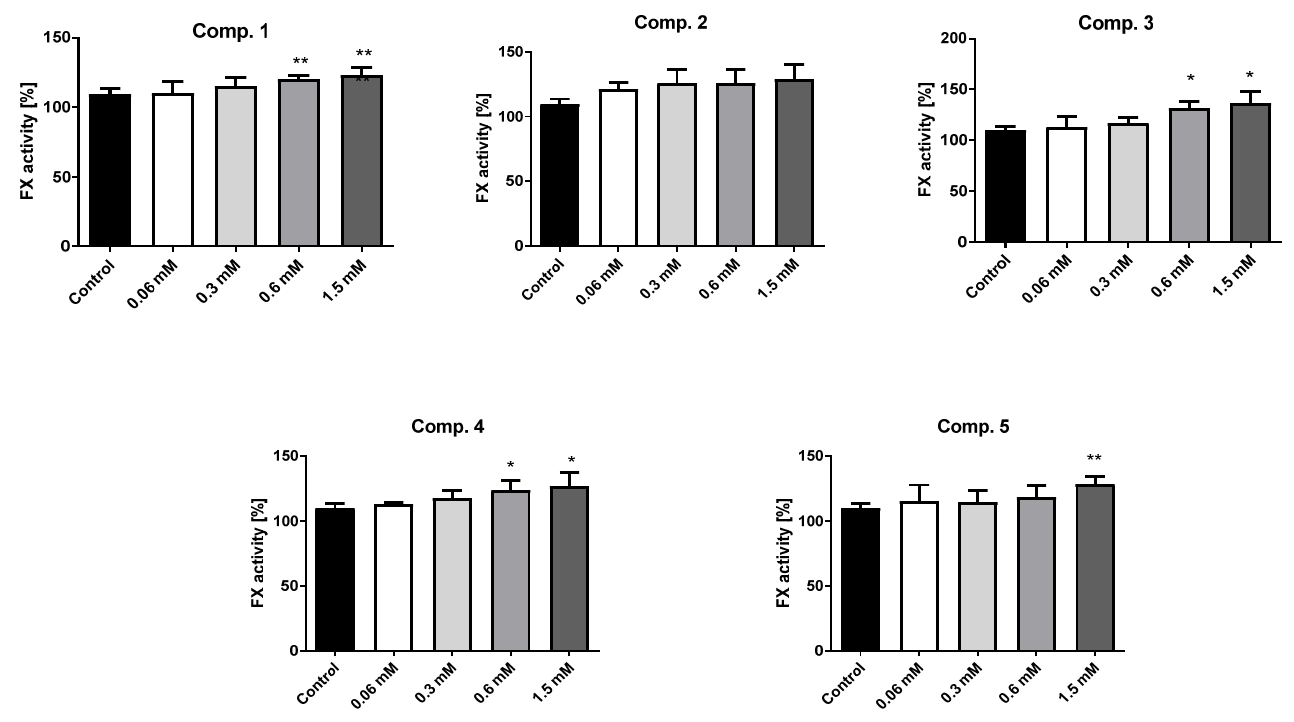
Figure 7. Effects of selected biguanides ( 1 – 5 ) on the activity of anti-thrombin III (AT) (data are presented as mean ± SD; n = 4). The asterisk denotes a statistically significant difference between the samples treated with compounds and control; * p < 0.05, ** p < 0.01.